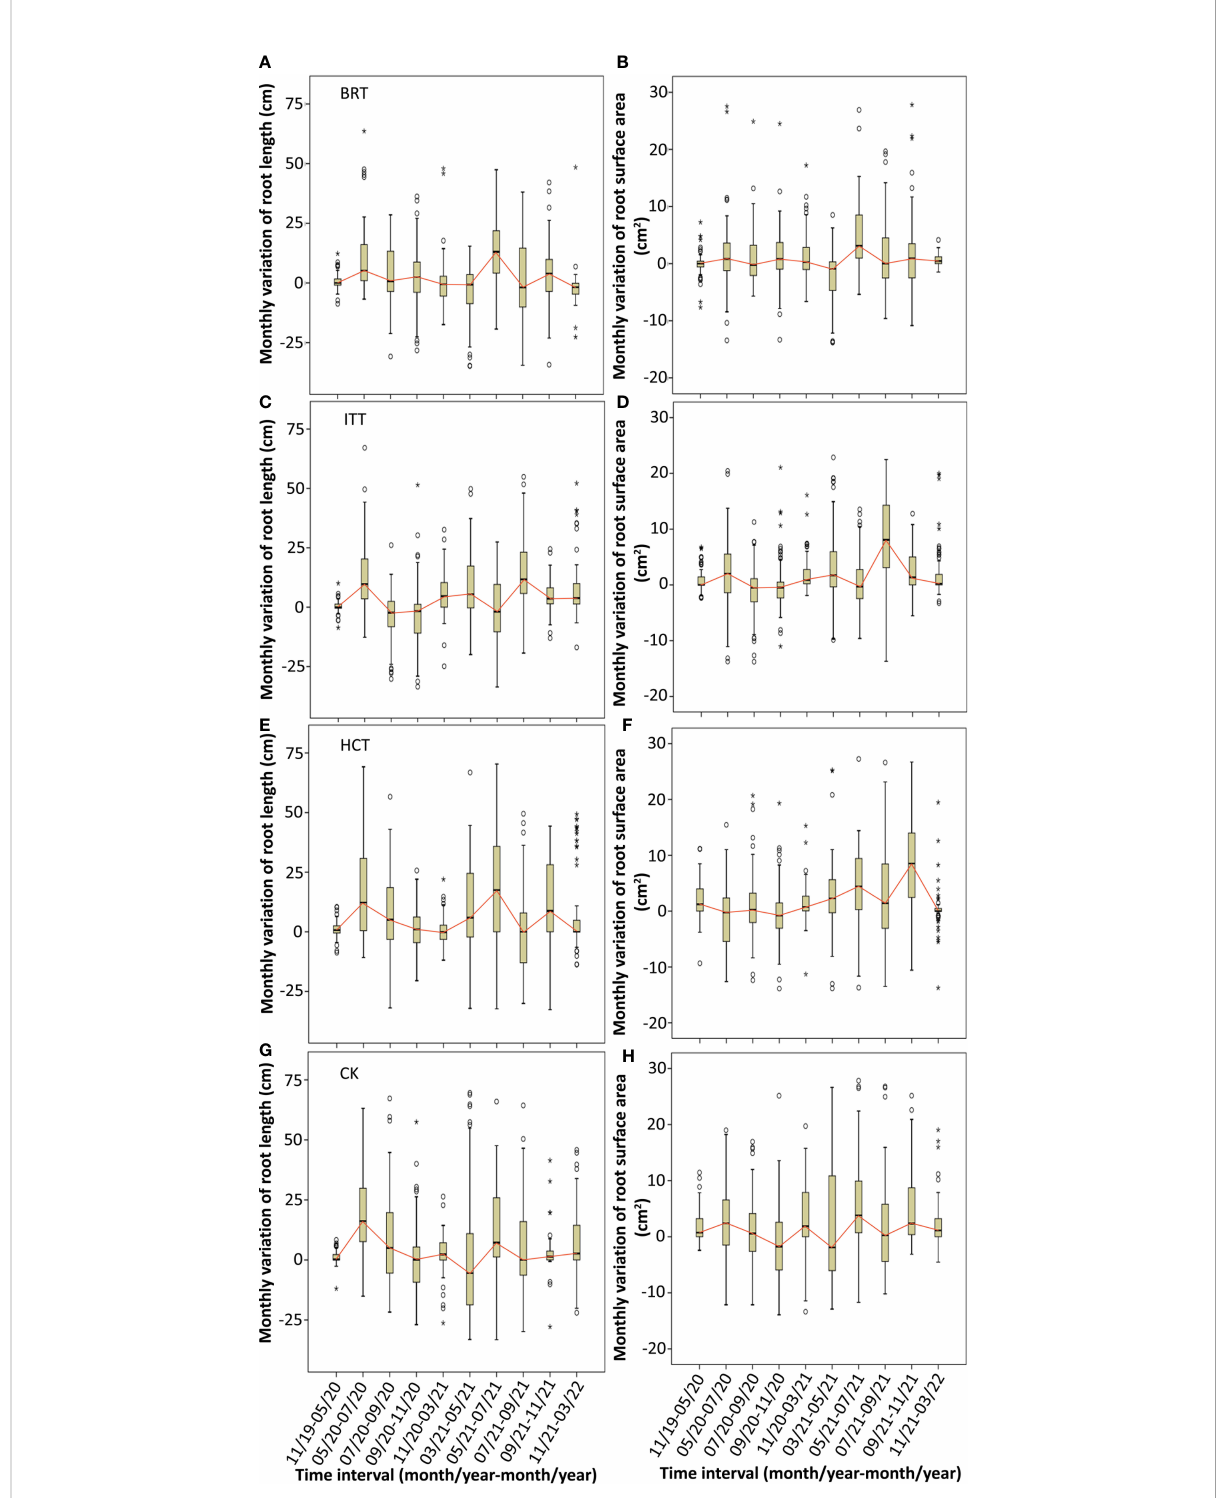
FIGURE 4 Monthly variation of root length (A, C, E, G) and root surface area (B, D, F, H) in the three treatments (BRT~ A, B ; ITT~ C, D ; HCT~ E, F ) and control (G, H) . Vertical boxes represent 50% of the observations (25th to 75th percentiles) and lines extending from each box are the upper and lower 25% of the distribution (90th and 10th percentiles). Within each box, the solid horizontal line is the median, the same below. The time interval was indicated as month/year-month/year. The years of 2019, 2020, 2021 and 2022 were abbreviated as 19, 20, 21 and 22 respectively, the same